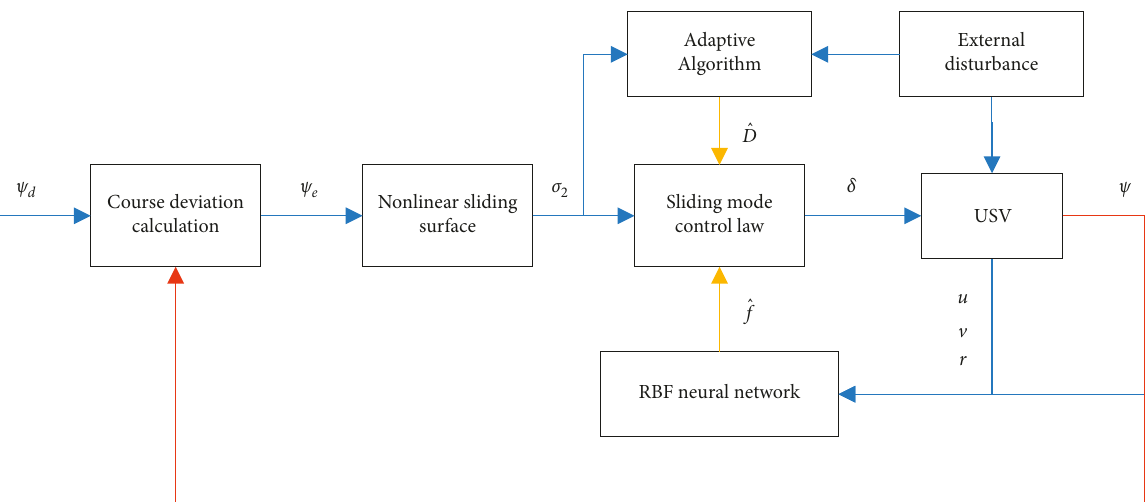
Figure 1: Structure diagram of adaptive-neural network iterative sliding mode heading tracking